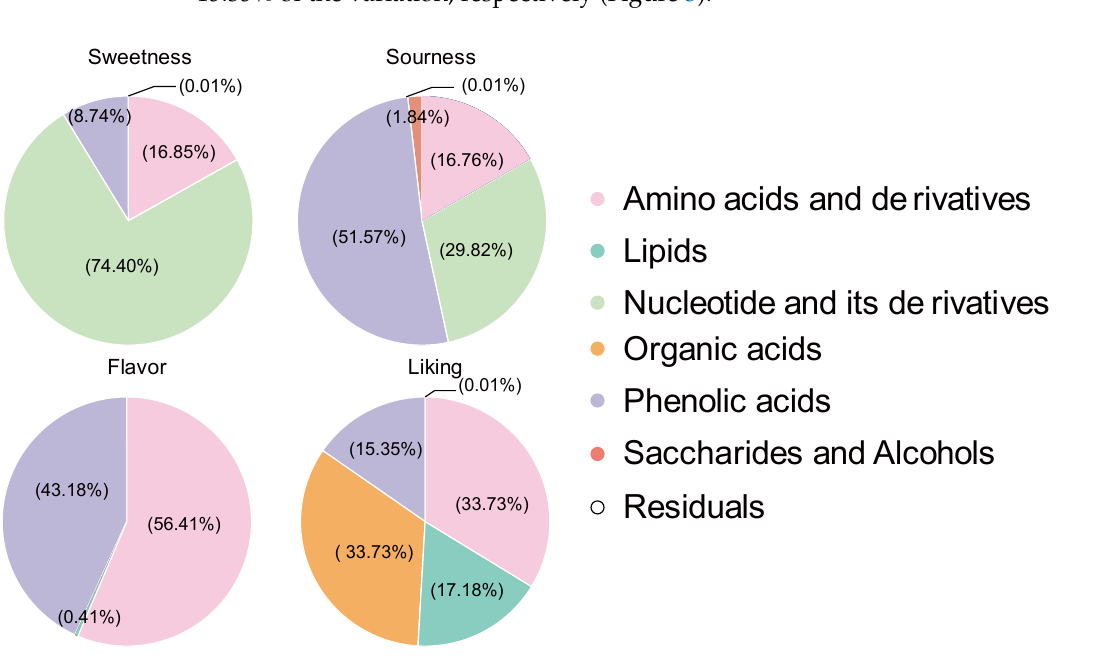
Figure 3. Contribution of metabolite groups to sensory characteristics.